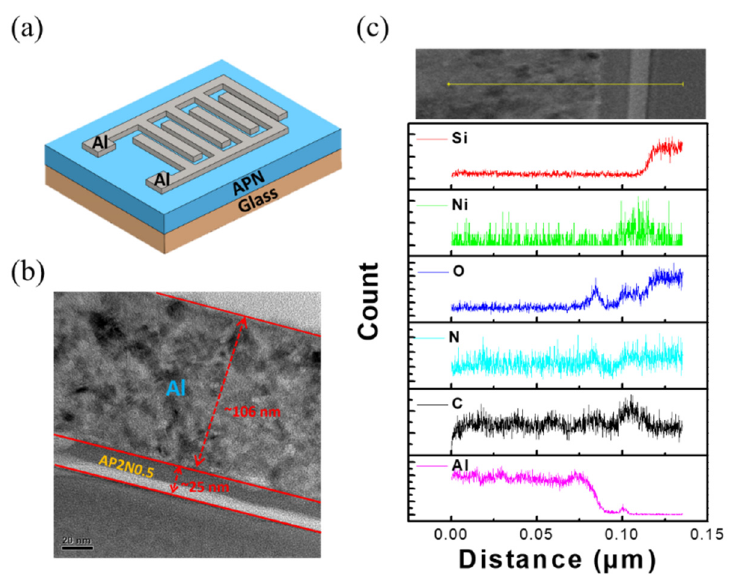
Figure 5. ( a ) Schematic illustration of gas sensor based on the APN film. ( b ) HR-TEM images of